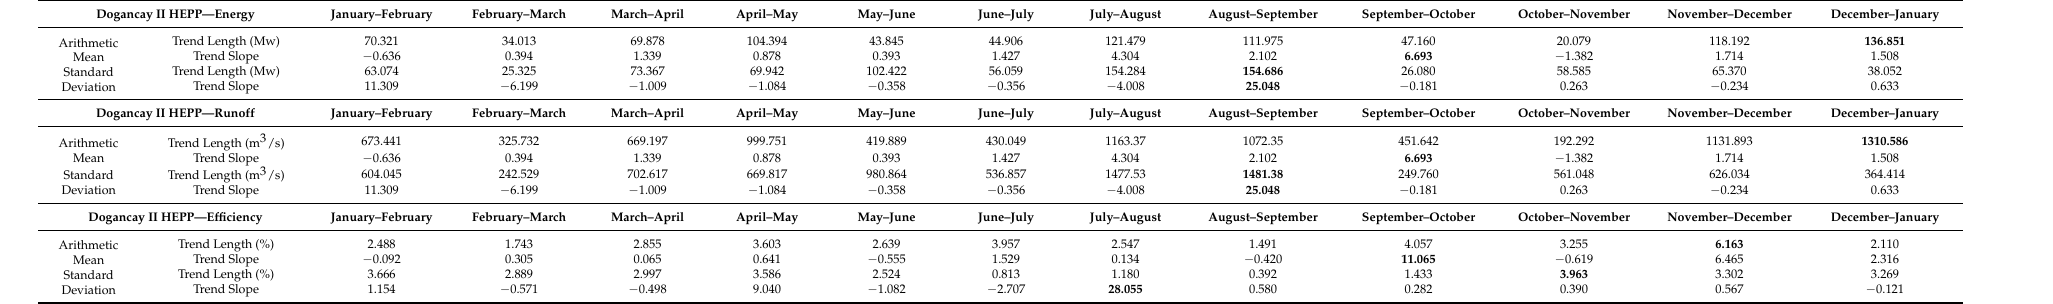
Table 5. Statistical Values of Arithmetic Mean and Standard Deviation of Dogancay II